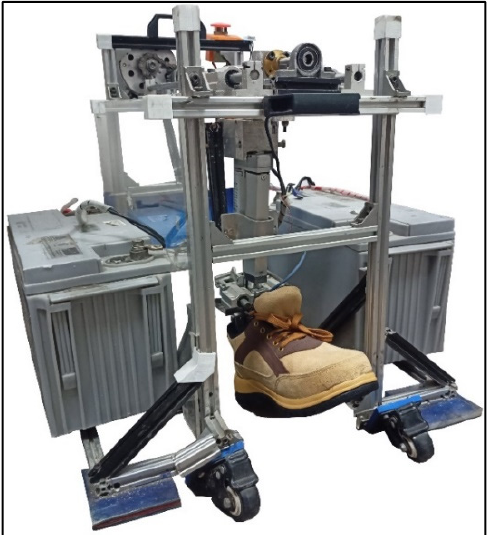
Figure 3. Biofidelic and portable whole-shoe robotic slip testing